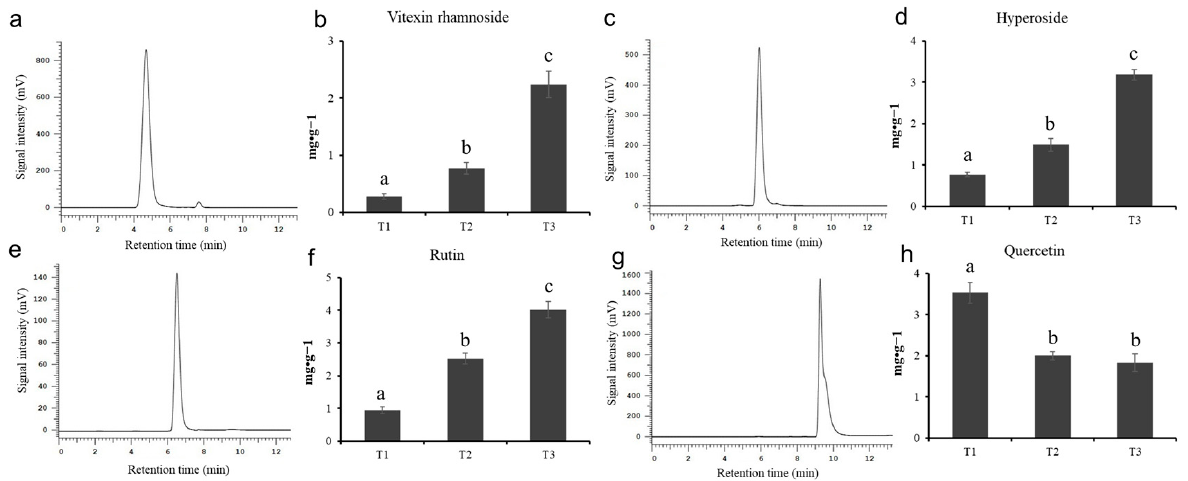
Figure 2. The standard chromatogram map and metabolite content. ( a , b ) Vitexin rhamnoside, ( c , d ) hyperoside, ( e , f ) rutin, ( g , h ) quercetin. The different letters (a, b, c) on the columns indicate the significance of the differences between each group, p < 0.05.